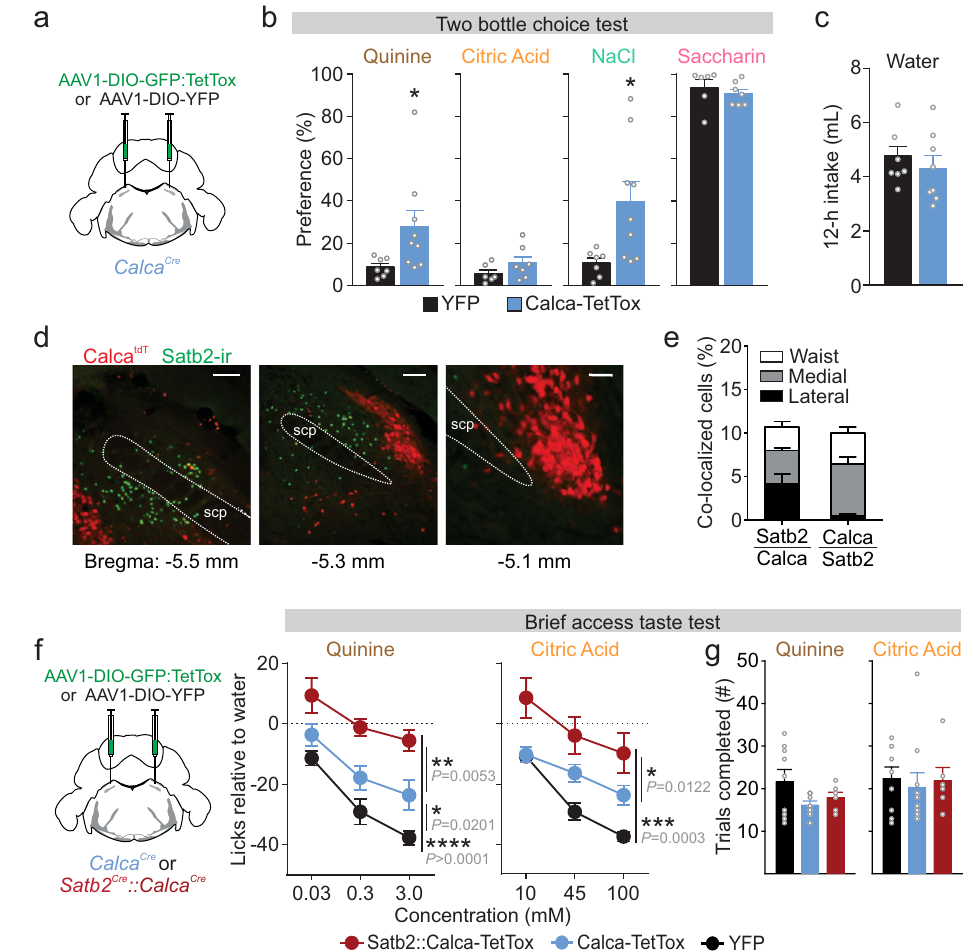
Fig. 5 CGRP neurons contribute to the avoidance of aversive tastes. a Calca Cre mice were injected bilaterally with either AAV1-DIO-GFP:TetTox or AAV1- DIO-YFP. b In 48-h, two-bottle choice tests, Calca-TetTox mice decreased avoidance of 0.3 mM quinine and 300 mM NaCl, but there was no change in their preference for 30 mM citric acid or 4.8 mM saccharin (two-tailed unpaired t test with Welch ’ s correction, YFP n = 5, TetTox n = 9. Quinine: t (8.737) = 2.384, P = 0.0417. NaCl: t (8.969) = 2.95, P = 0.0163, two-tailed unpaired t test, YFP n = 6, Tetox n = 7. Citric acid: t (11) = 1.405, P = 0.1876. Saccharin: t (11) = 0.7602, P = 0.4631.) c There was no difference in overnight water intake ( n = 8 per group, two-tailed unpaired t test, t (14) = 0.7712, P = 0.4534). d tdTomato expression in the PBN of a Calca tdT mouse (red), with immunostaining showing minimal colocalization with Satb2 (green). Scale bars, 100 µ m. scp superior cerebellar peduncle. e Quanti fi cation of overlap between tdTomato in Calca tdt mice and immunolabeled Satb2 neurons in the PBN. f In brief- access taste tests, mice with TetTox in both Satb2 and CGRP neurons were unable to detect aversive tastes (two-way RM ANOVA; quinine: YFP n =